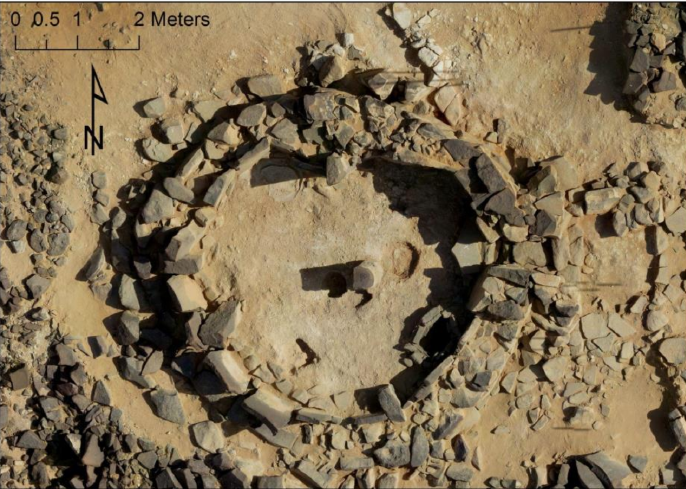
Figure 11. Orthophotograph of Structure SS1, a Late Neolithic building on the slope of Mesa